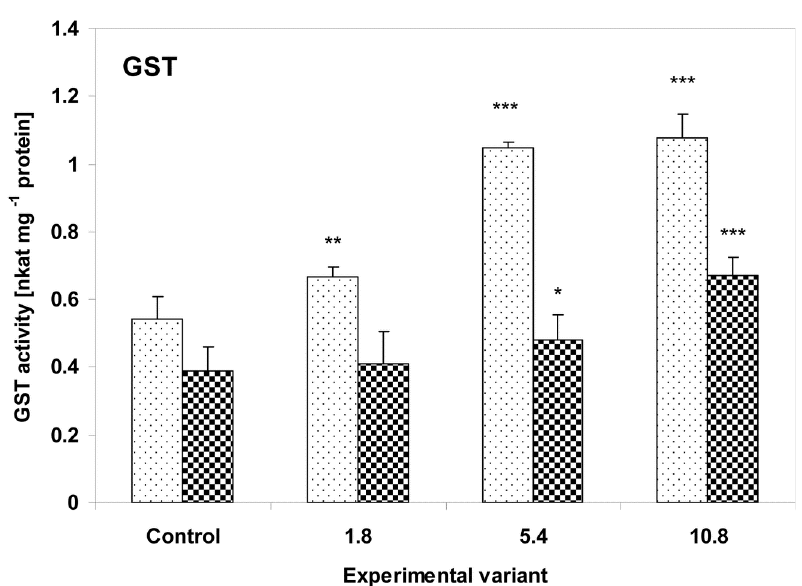
Fig 7. The activity of GST in the leaves of zucchini (square without filling) and cucumber (square with dots) grown on the control and sewage sludge amended soil. Activities are expressed in nkat mg -1 protein. For further explanation, see Fig